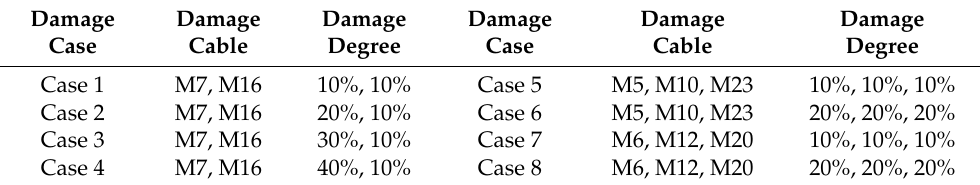
Table 3. Multiple-cable damage